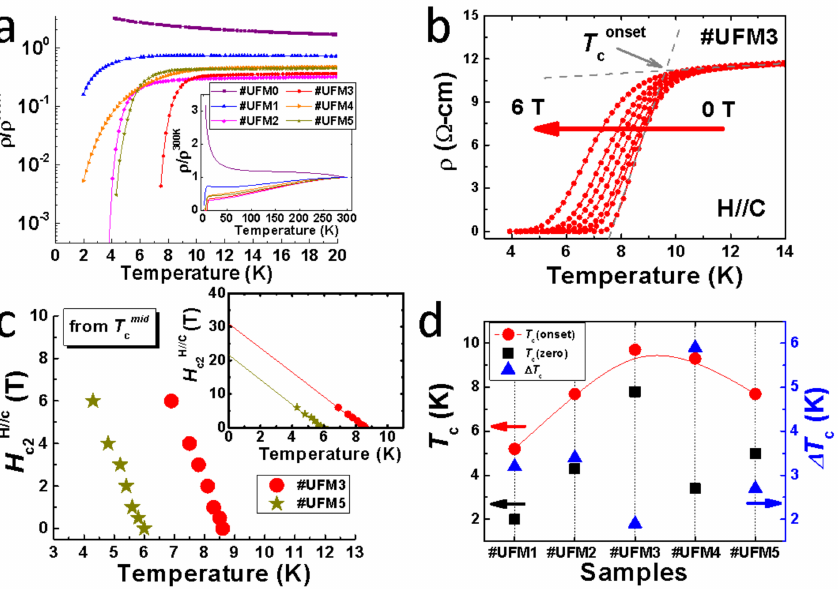
Figure 2. The results of resistivity behaviours of all samples in this work. ( a ) The temperature dependence of normalized resistivity ρ / ρ 300K up to 20 K. The y -axis is in logarithmic scale. Inset: temperature range up to 300 K. The y -axis is in linear scale; ( b ) ρ - T measurements for #UFM3 under external fields up to 6 T (parallel to c-axis); ( c ) Plots of H c2 as a function of T cmid for #UFM3 and #UFM5. Inset: the linear extrapolations to T = 0 K; ( d ) The evolution of T conset , T czero , and ∆ T c with different amount of Mg-coating. The left y -axis refers to the T conset and T czero , and the right y -axis stands for the ∆ T c